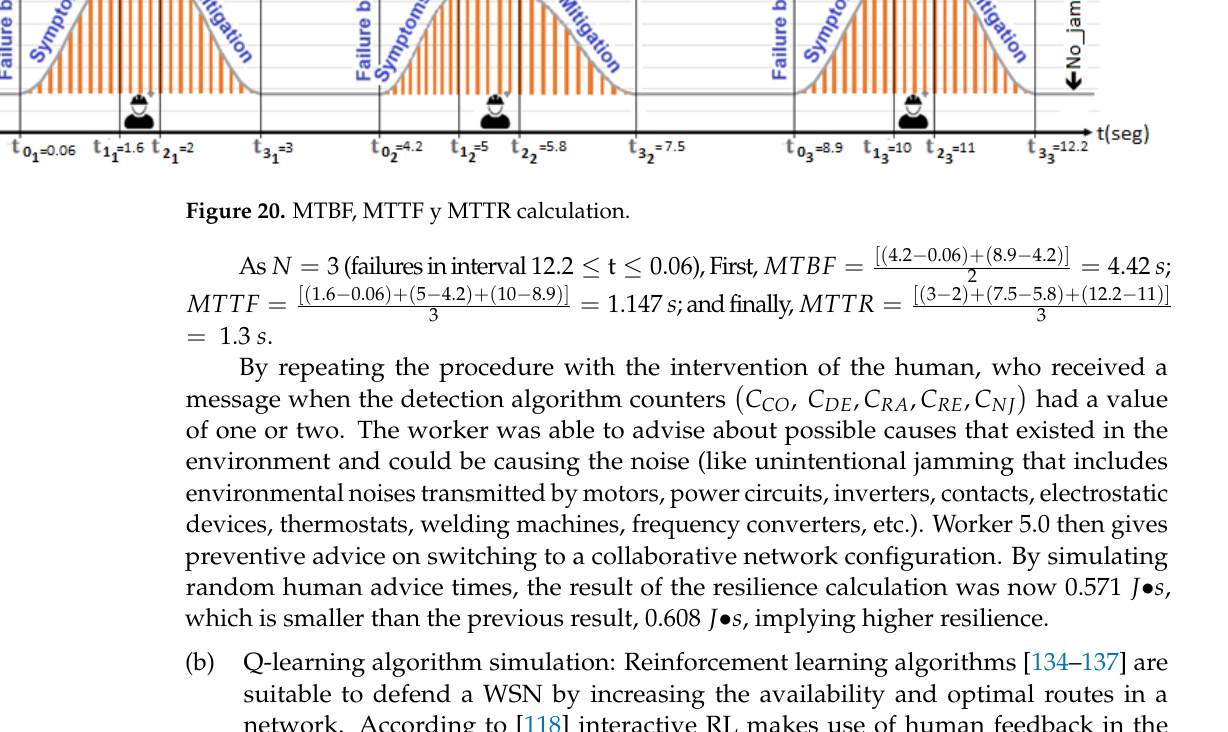
Figure 20. MTBF, MTTF y MTTR calculation.